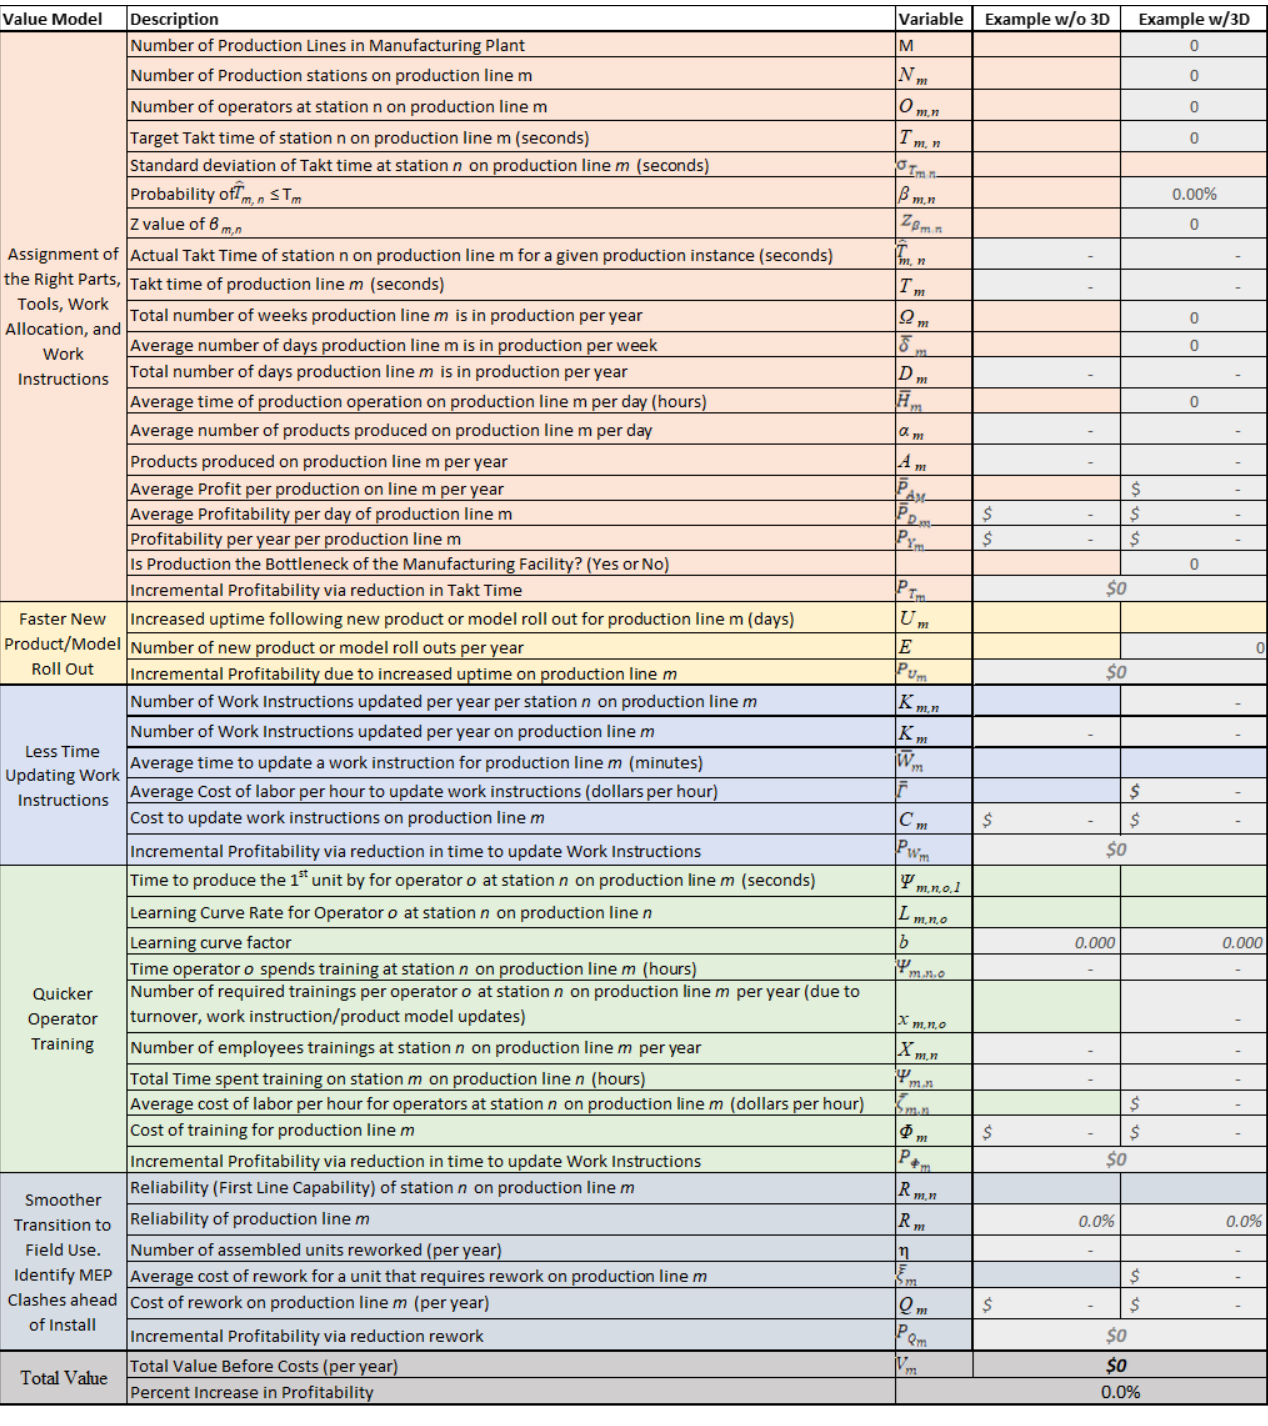
Figure 2. The 3D Product Model Value in Production Process — Quantitative Model Input Sheet. Prior to analyzing the survey results, the research team’s hypothesis was that the quantitative model would show the greatest value generation in each identified area (ac- curacy of assignment of the right parts, tools, work allocation, and work instructions; faster new product/model roll out to production; less time updating work instructions; quicker operator training; smoother transition for field use) to a similar magnitude as the qualitative results had showed in the prior research. Thus, as an example, accuracy of assignment of the right parts, tools, work allocation, and work instructions would show